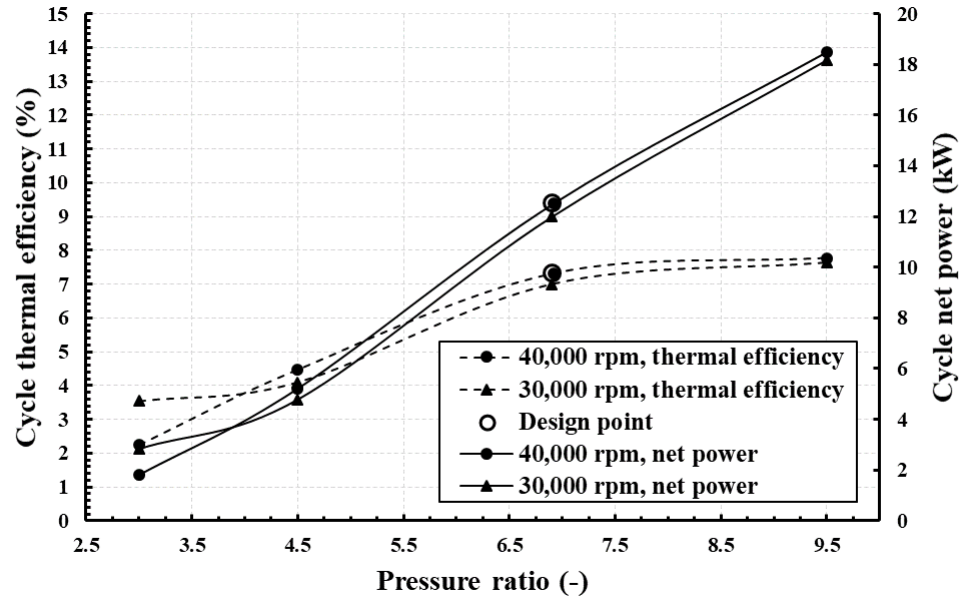
Figure 26. Cycle thermal efficiency and net power at various pressure ratios.